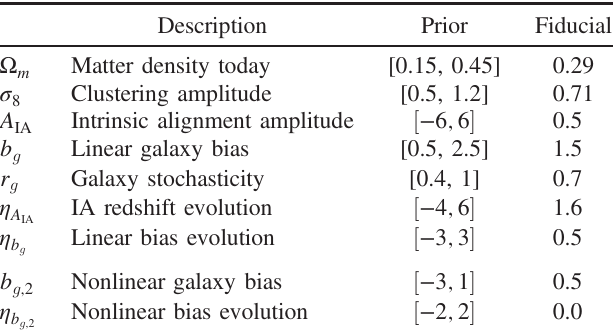
TABLE I. Summary of parameters used in the data models. Parameters b and η are used only in the nonlinear galaxy g; 2 b g; 2 bias model. Parameters Ω and σ 8 are additionally restricted by m convex hull prior defined by the simulation